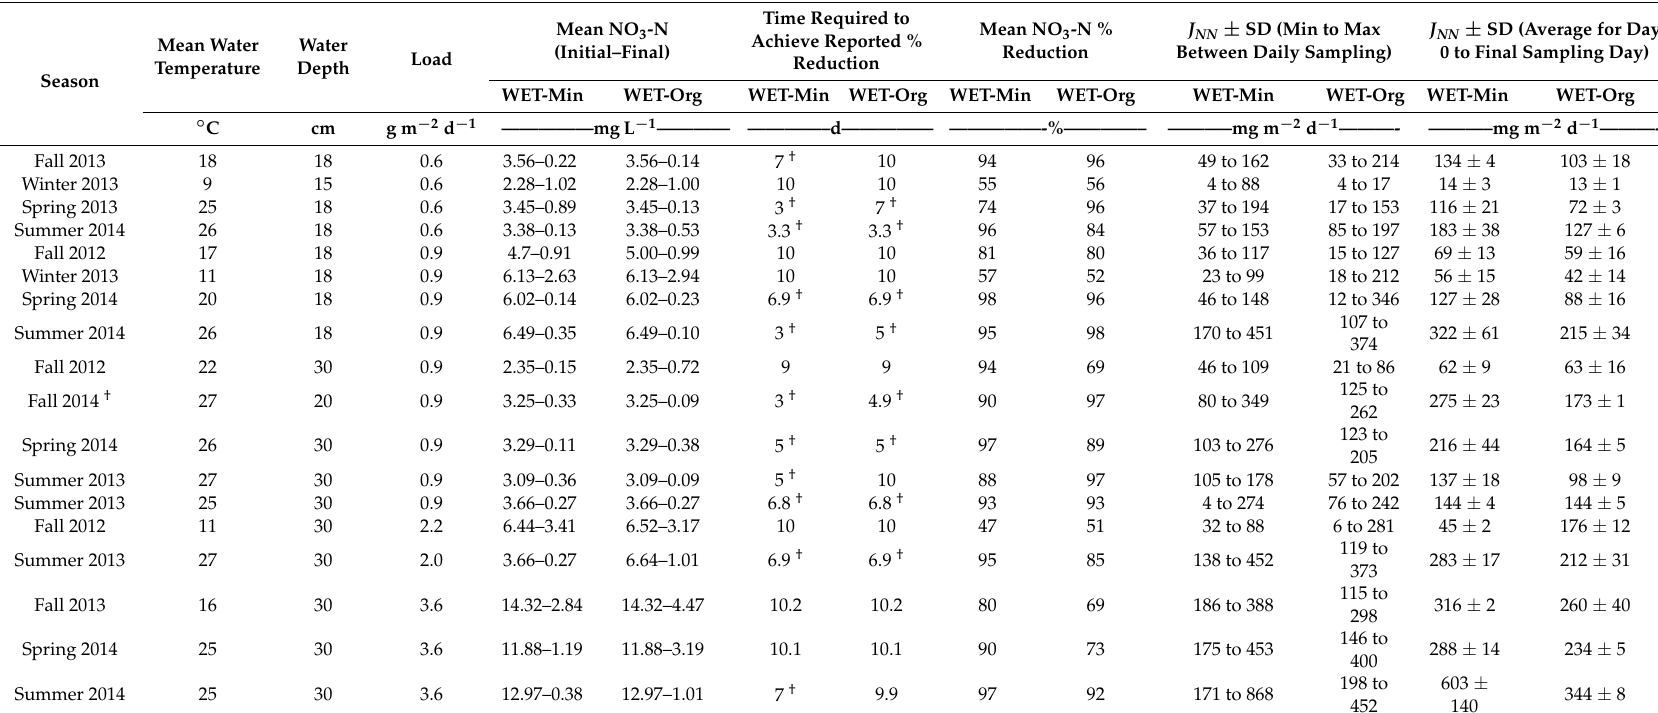
Table 3. Summary of selected water quality parameters during batch experiments and NO 3 -N removal rate means ± standard deviations